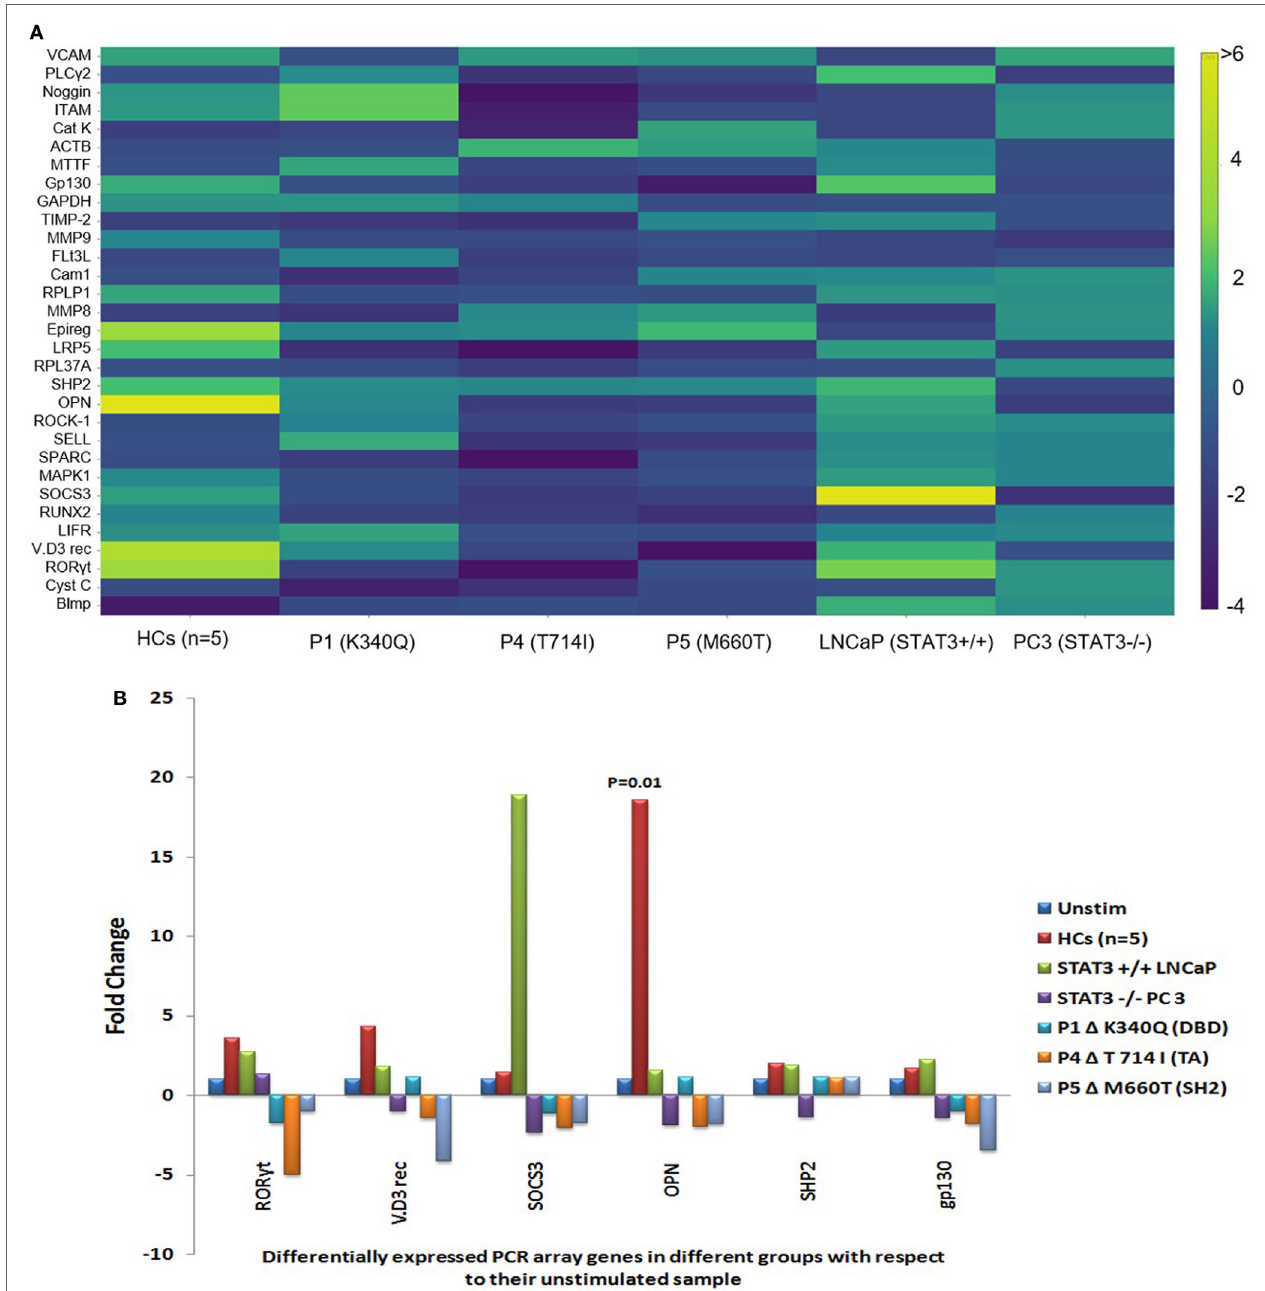
FigUre 2 | (a) Heat map of gene expression profile of HCs, hyper-IgE syndrome (HIES) subjects, LNCaP, and PC-3 cells generated using Plotly software (https://plot.ly). Scale bar − 4 to + 6 and > 6. Fold change values were calculated using RT2 PCR array analysis software (Qiagen), an online tool. (B) Bar graphs showing differentially expressed genes in the PCR Array post IL-6 stimulation of HCs, LNCaP cells, PC3 cells, and HIES subjects with respect to their unstimulated samples. Data were normalized to mean C t value of β -actin , GAPDH , and RPL37A genes. Statistical significance was determined by Student’s t -test (* p < 0.05, ** p < 0.01, *** p < 0.001) using RT 2 PCR Array Analysis software,